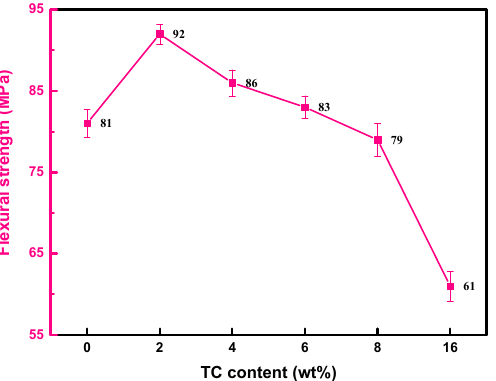
Figure 13. Flexural strength of the TC composites with various TC contents sintered at 950 °C for 1 h.